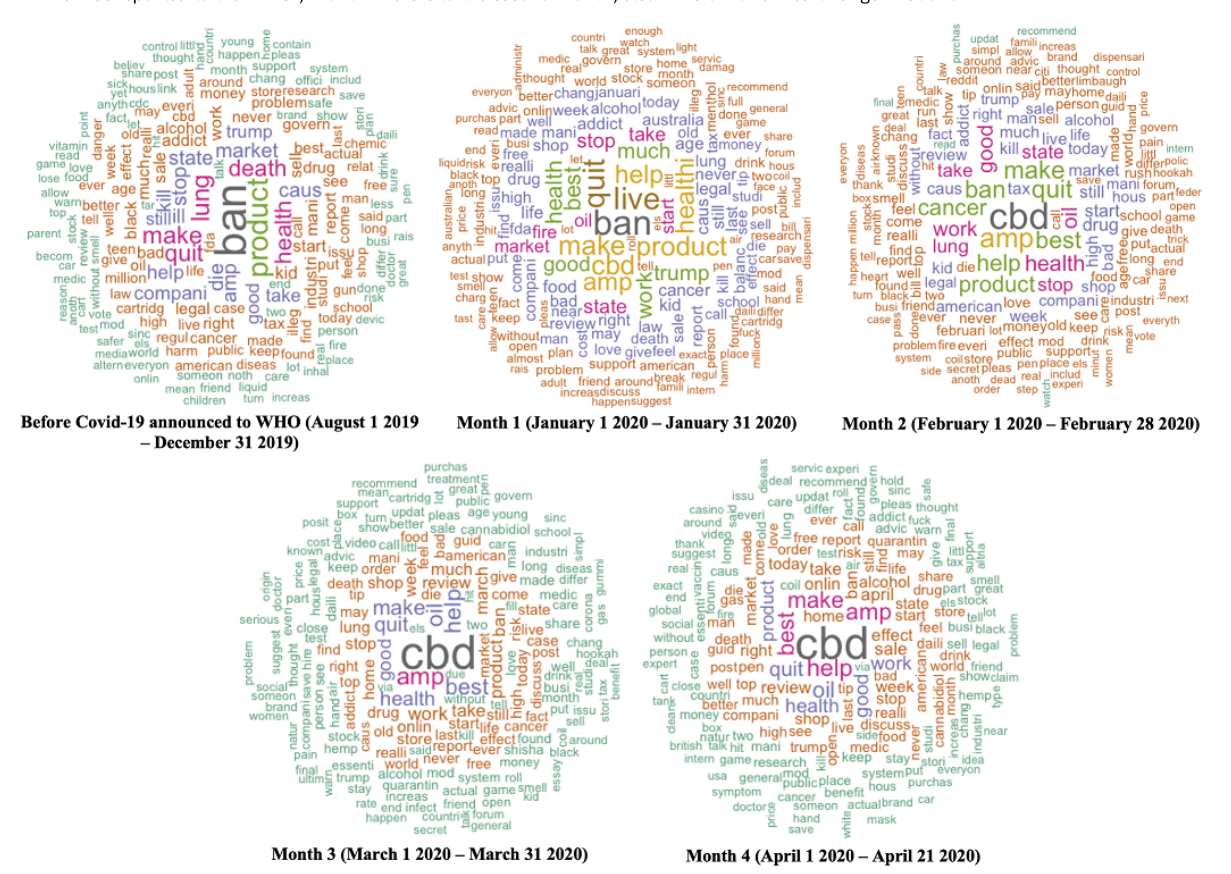
Figure 1. Word clouds showing the 200 most frequently occurring words in the examined documents over time. Month 1 refers to the first month